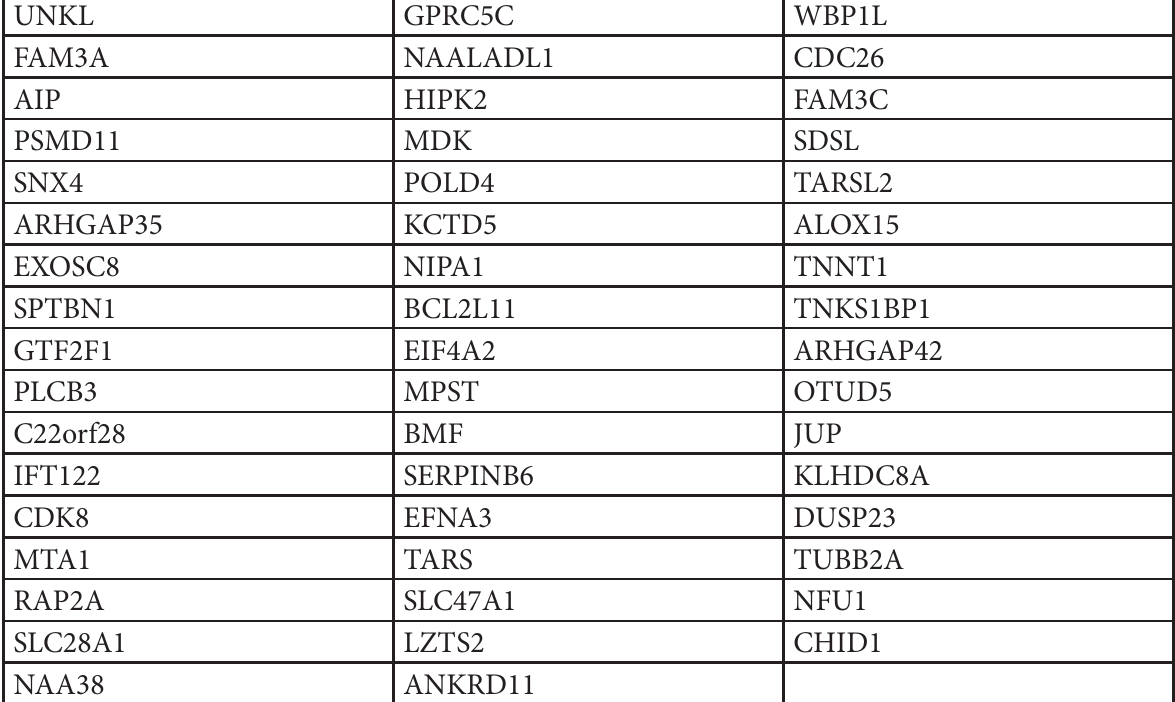
Supplementary Table 1 . Top 50 Genes Used for DAVID